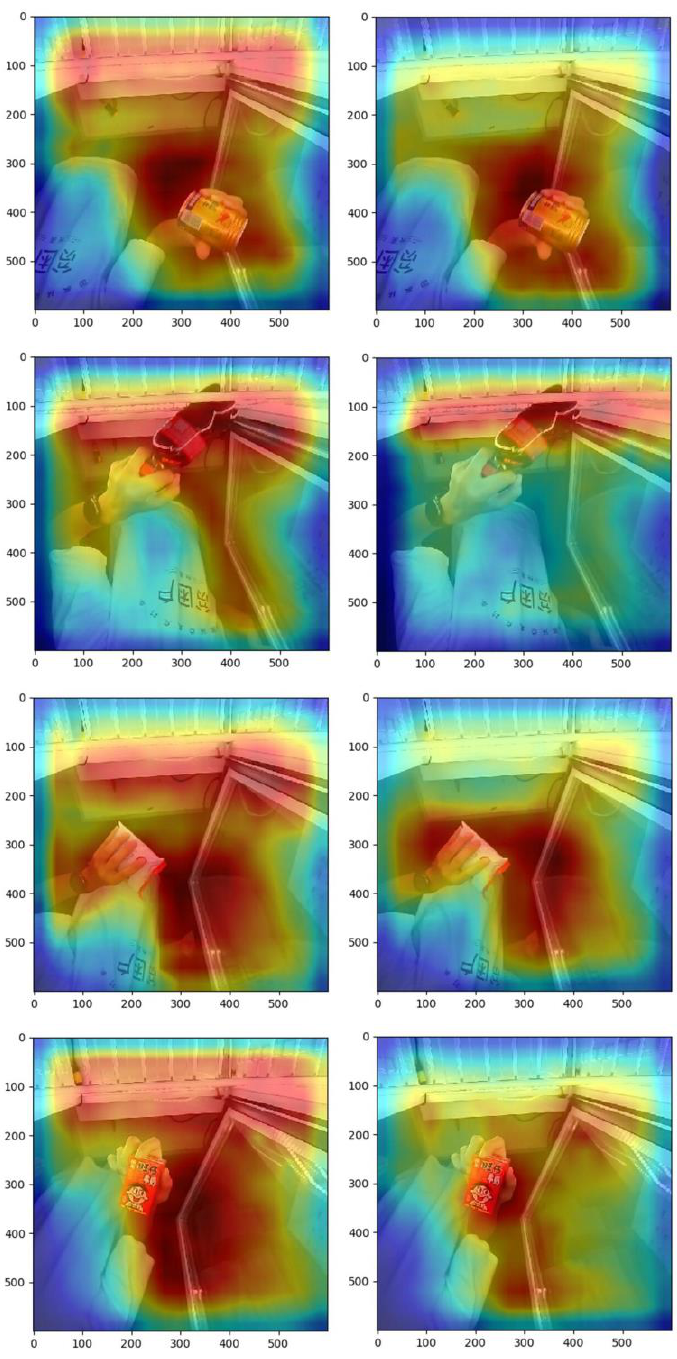
Figure 13. Heatmaps with and without the attentional mechanism. The left and right panels, respectively, show heatmaps without and with the attention mechanism. Evidently, under the effect of the attention mechanism, the network focus area is significantly reduced, and the network extracts more refined commodity regional features from the channel and spatial dimensions, improving the efficiency of commodity feature extraction to a certain extent. In addition, it further verifies the feasibility and scientificity of using the attention mechanism in the network.